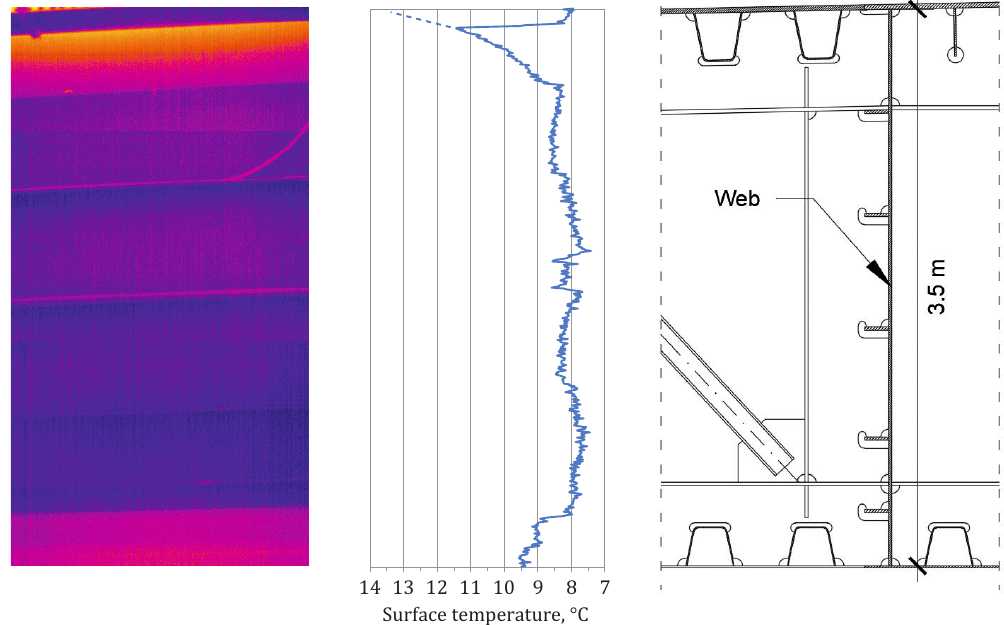
Figure 10. Thermogram and temperature profile of internal web, 1 April 2019, time 13:30. Effect of heating with solar radiation on the deck is visible in the upper part of element only. Extrapolation of the temperature curve is proposed (broken